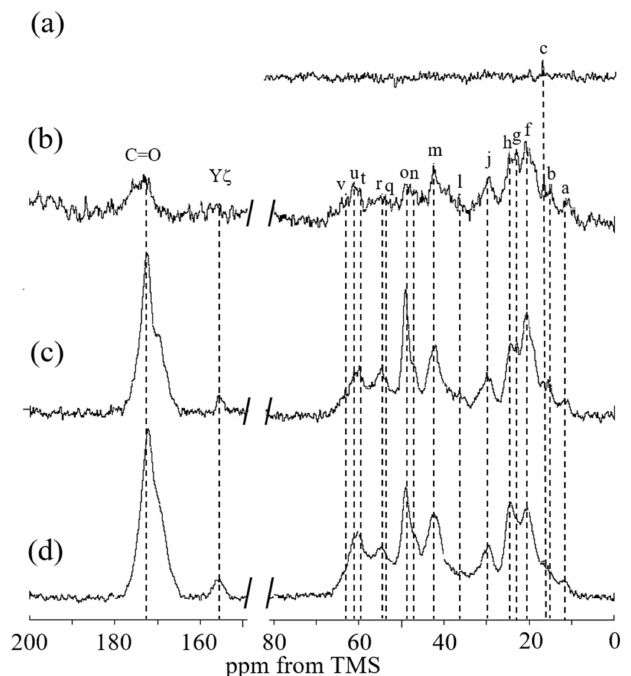
Figure 10. ( a ) 13 C r‑INEPT, ( b ) 13 C DD/MAS, ( c ) 13 C CP/MAS NMR spectra of RSSP(VLI) powder after methanol treatment in the hydrated states, and ( d ) 13 C CP/MAS NMR spectrum in the dry state. The peak assignment is shown in Figure 9.